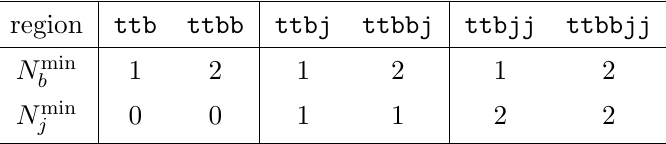
N min ) that pass the acceptance cuts (3.11). j (cid:21)